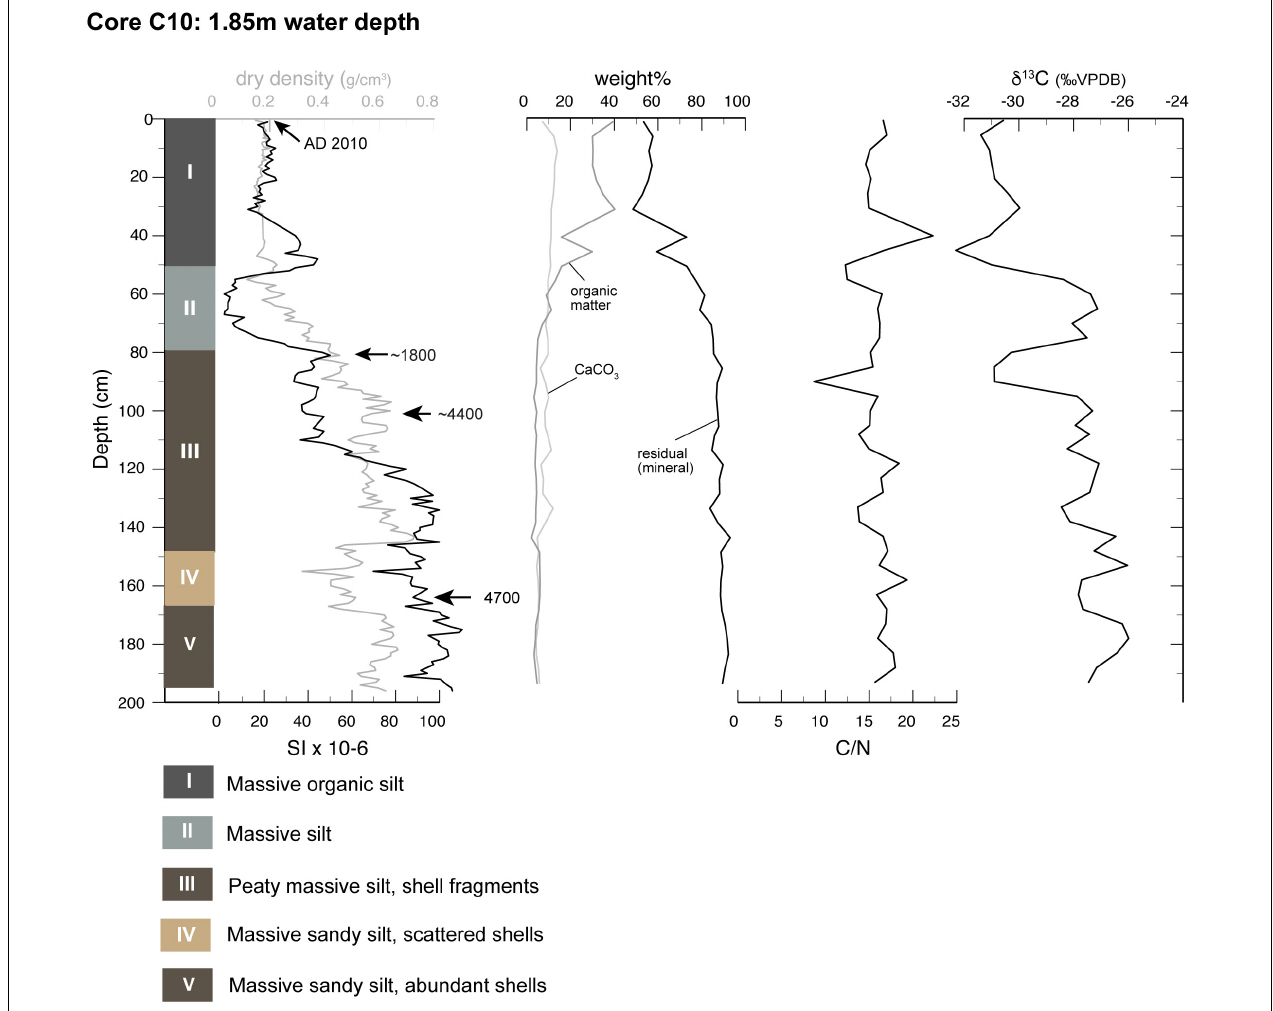
FIGURE 8 | Sediment core C lithology, physical and geochemical properties, and corrected radiocarbon ages in cal yr BP (arrows): magnetic susceptibility (SI × 10 - 6 ), dry bulk density (g/cm 3 ), weight percentages (weight%) calcium carbonate (CaCO 3 ), organic matter, and residual mineral matter, organic C/N ratio, organic matter δ 13 C values ( (cid:104)